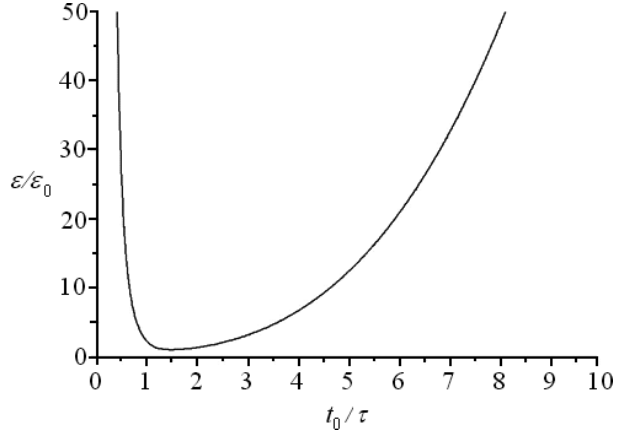
Fig. 3. Energy needed to initiate fracture vs . impact duration ( σ c = 700 MPa and τ = 8 µ